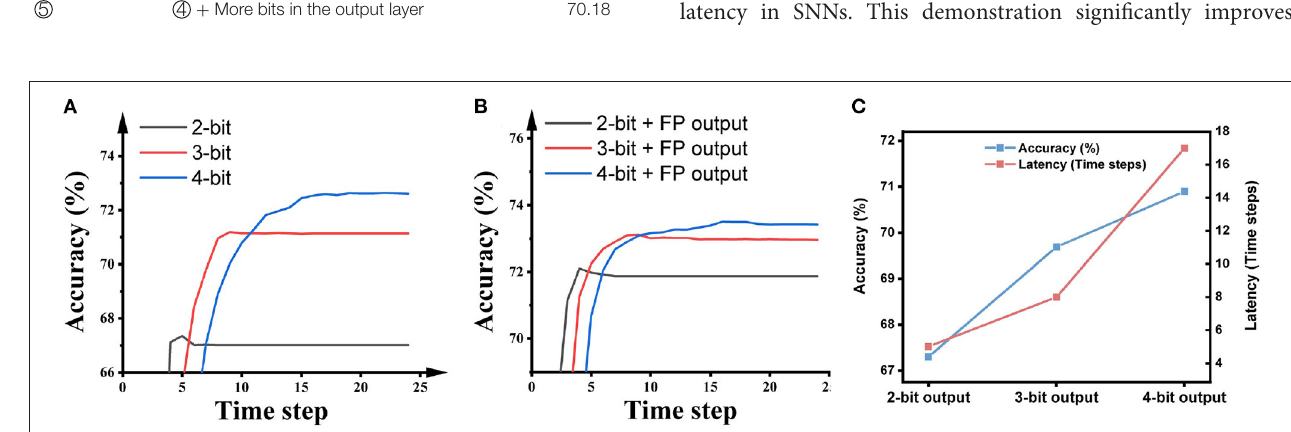
FIGURE 9 | The impact of the bit precision in (A) all layers, (B) all hidden layers, and (C) the output layer on SNN accuracy and latency. The output precision in (B) is floating-point; the precision of hidden layers in (C) is 2 bits. The dataset is ImageNet and the network architecture is VGG-16.